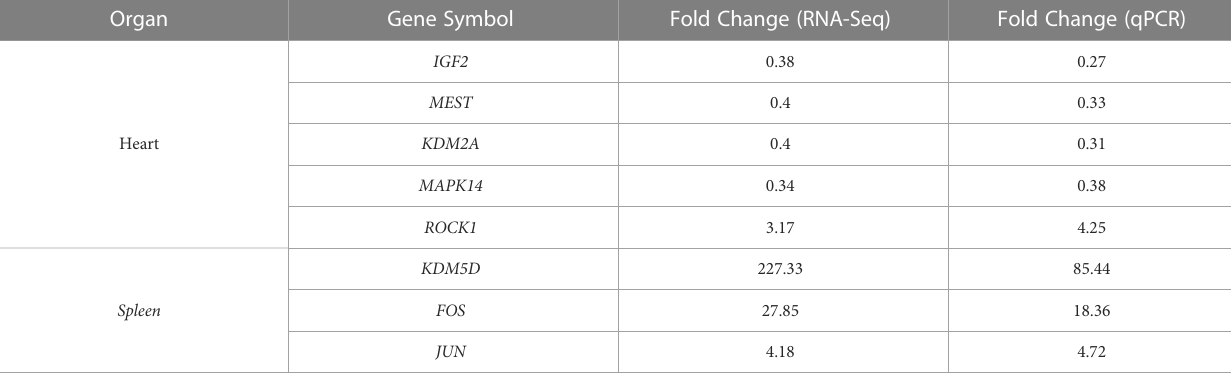
TABLE 2 qPCR validation of gene expression in offspring affected by ART.